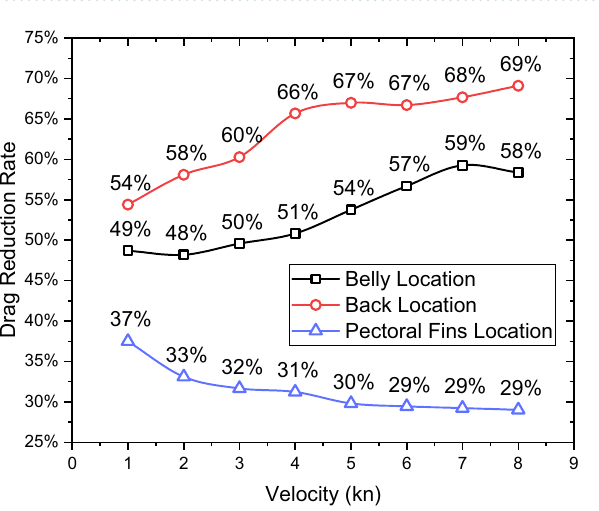
Figure 20. Different meshing scenarios with the remora fish attached to the shark ( a ) at the belly, ( b ) at the back and ( c ) at the pectora fin (Created using Simcenter STAR-CCM + 2019.2.1 Build 14.04.013).